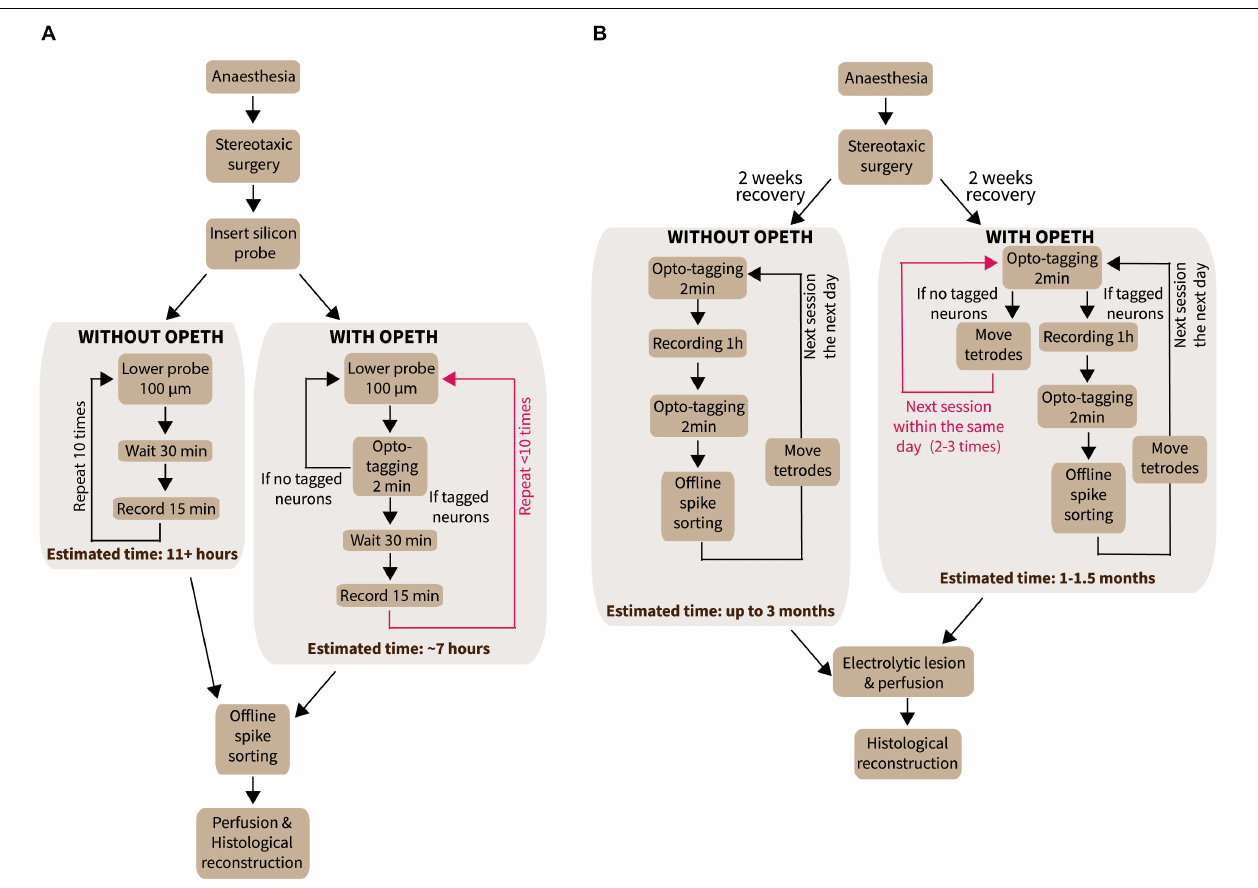
FIGURE 5 | Experiments performed with OPETH. (A) Workflow of acute anesthetized experiments with or without OPETH. OPETH saved more than 4 h per experiment on average. (B) Workflow of chronic recording experiments in awake behaving mice with or without OPETH. Using OPETH in chronic tetrode recording experiments, we were able to make several tagging sessions within the same day, without having to record and process all data, thus allowing us to take faster decisions and save up to 2 months of training and